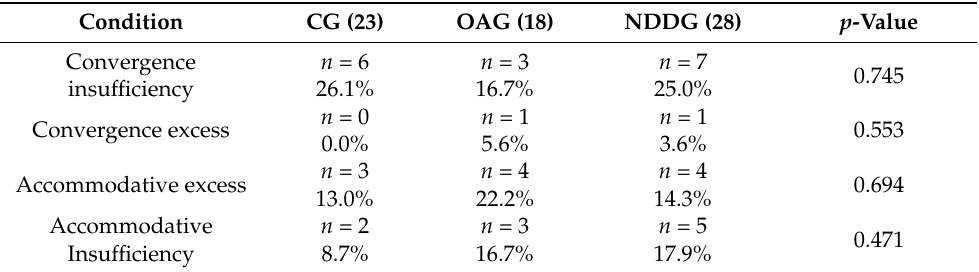
Table 7. Distribution of the different accommodative and binocular anomalies diagnosed in the three groups of children evaluated: CG, control group; OAG, group of children with oculomotor abnormalities; NDDG, group of children with neurodevelopmental disorders.